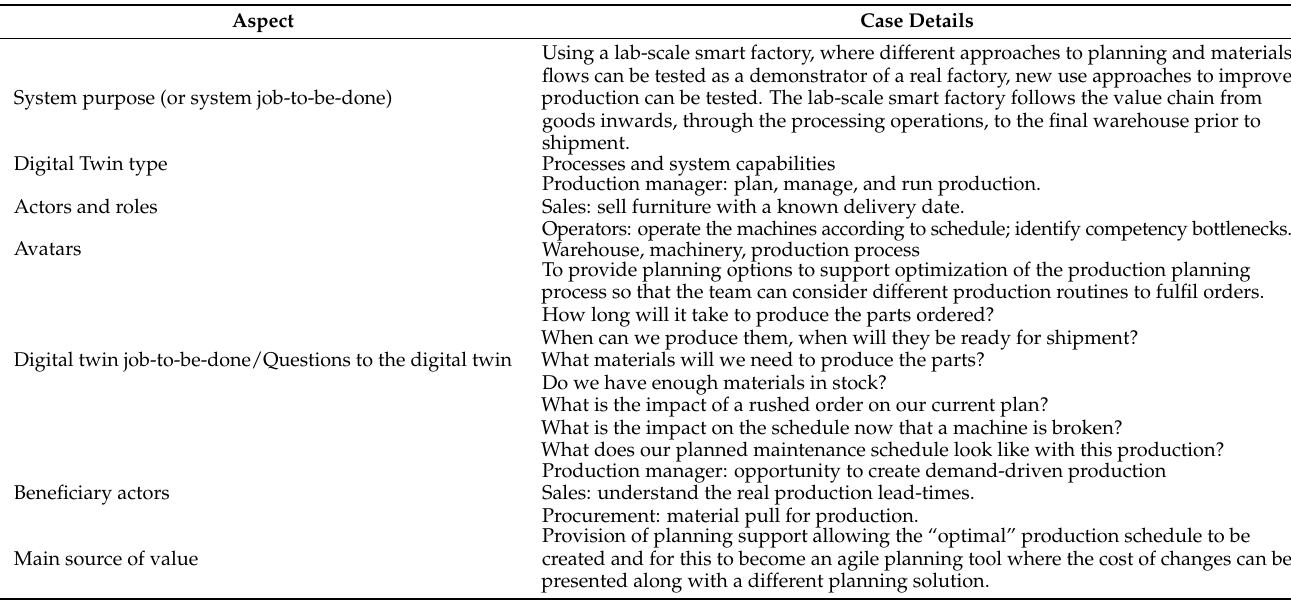
Table A6. Case 4—operations smart factory planning and materials flow.